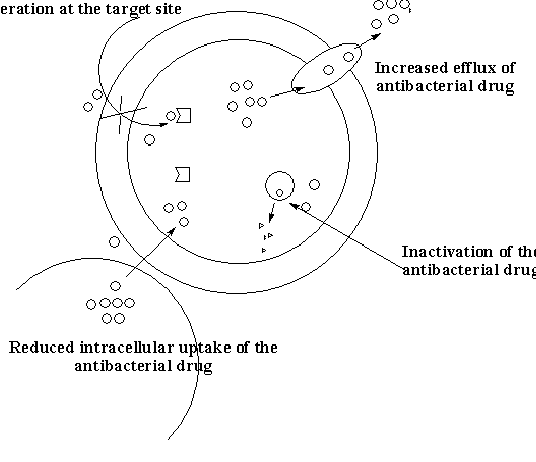
Figure 1. Mechanism of resistance of bacteria.